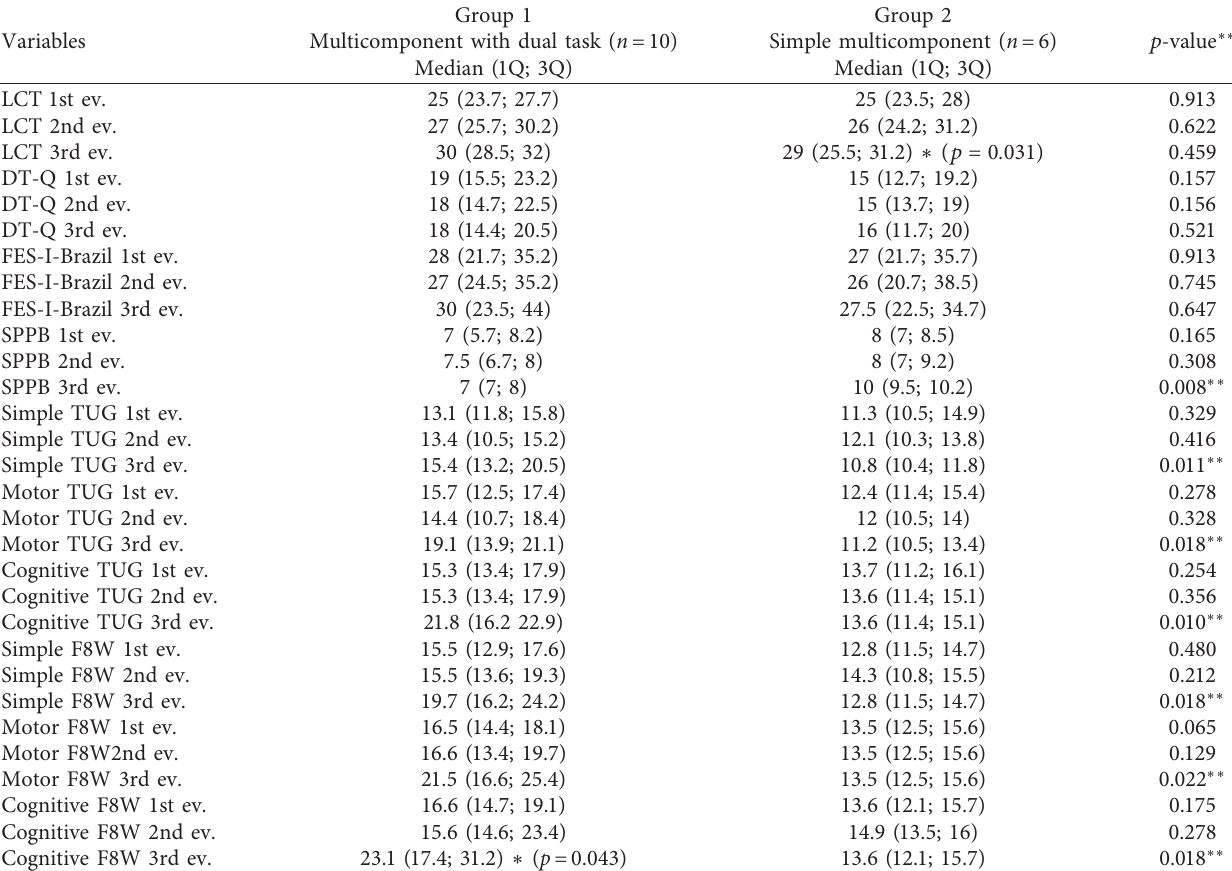
Table 4: Measurement instruments and functional tests in the three